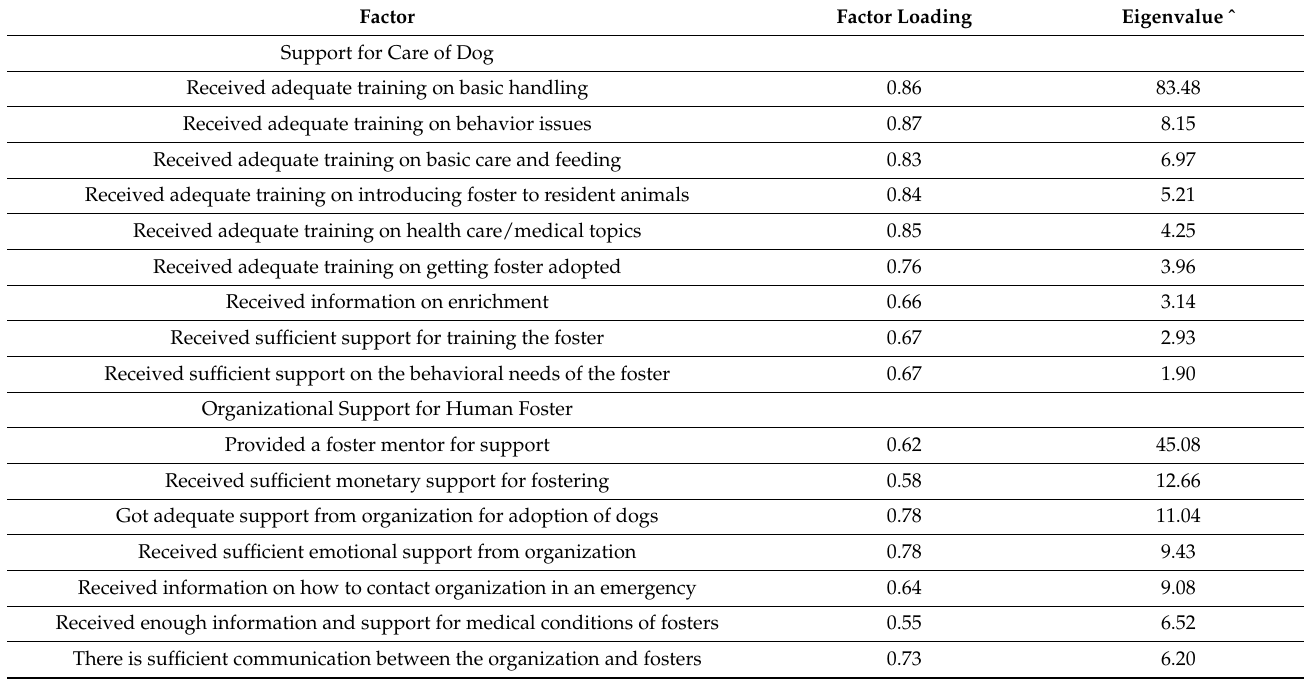
Table 1. Factor analysis of questions regarding organizational